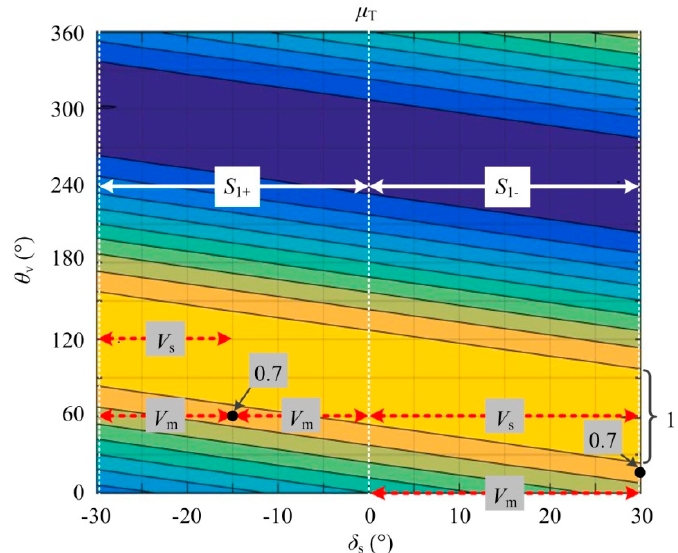
Figure 7. Two-dimensional contour map of torque error active factors.